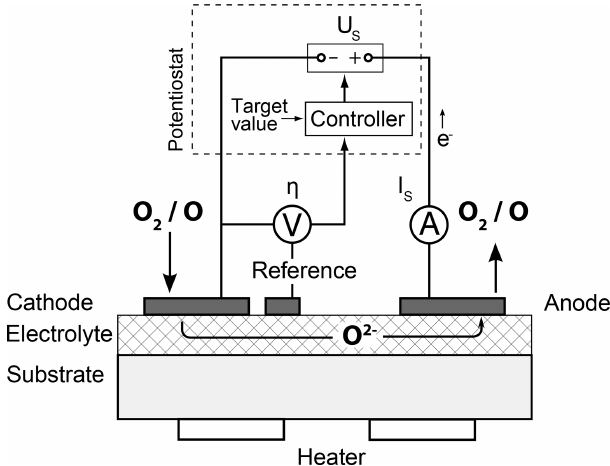
Figure 2. Schematic circuit of sensor electrodes.